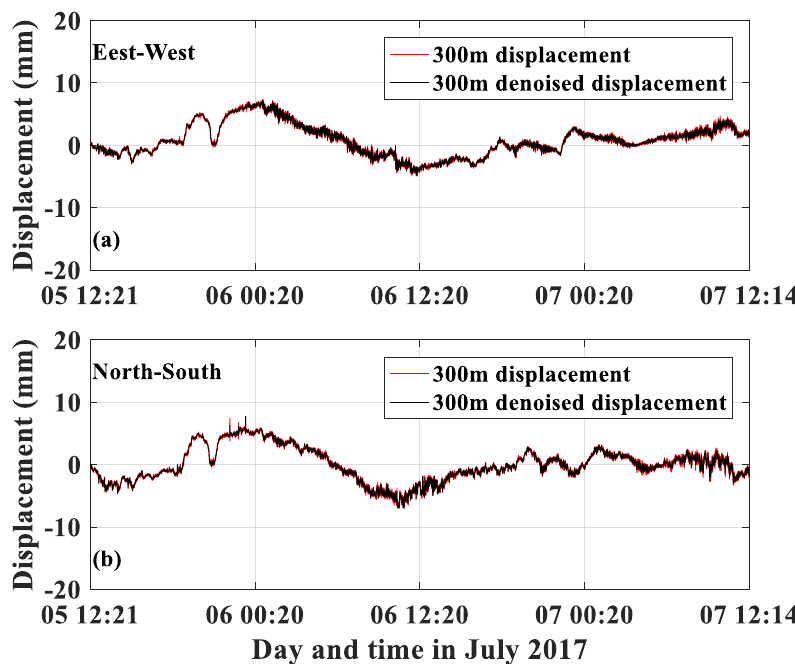
Figure 9. IBIS-S-derived horizontal displacement time series in east–west (a) and north–south (b) directions at 300 m height of the WGC. The red line indicates the displacement time series without denoising, and the black line denotes the displacement time series after denoising.